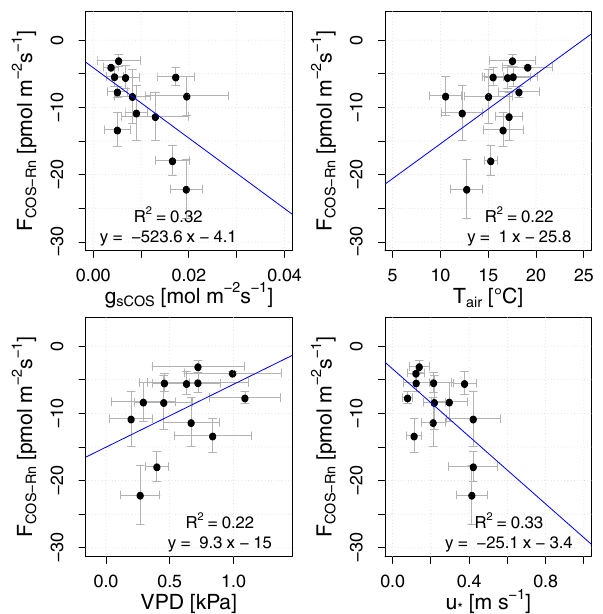
Figure 5. Correlations of F COS-Rn with g sCOS , T air , VPD, and u ∗ . All data (except F COS-Rn ) are averages over individual nights (with nighttime defined as sun elevation below − 3 ◦ ). Data in this plot largely represent a period in August 2015 with dry conditions (i.e., decreasing SWC, and increasing T air and